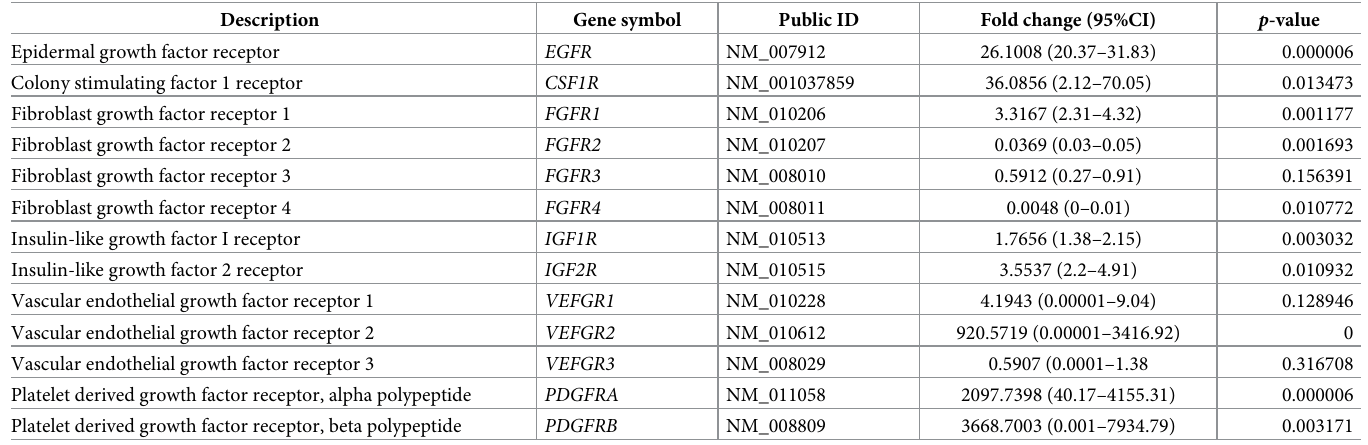
Table 1. Expression of tyrosine kinase receptors of PIS-1 on PCR